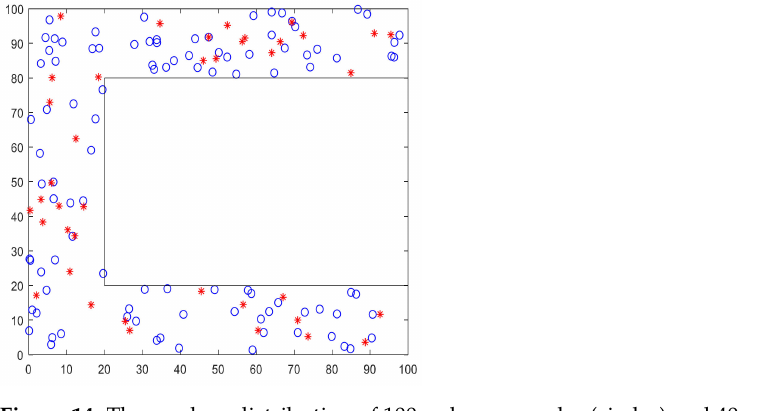
Figure 14. The random distribution of 100 unknown nodes (circles) and 40 anchor nodes (asterisks) on a C-shaped